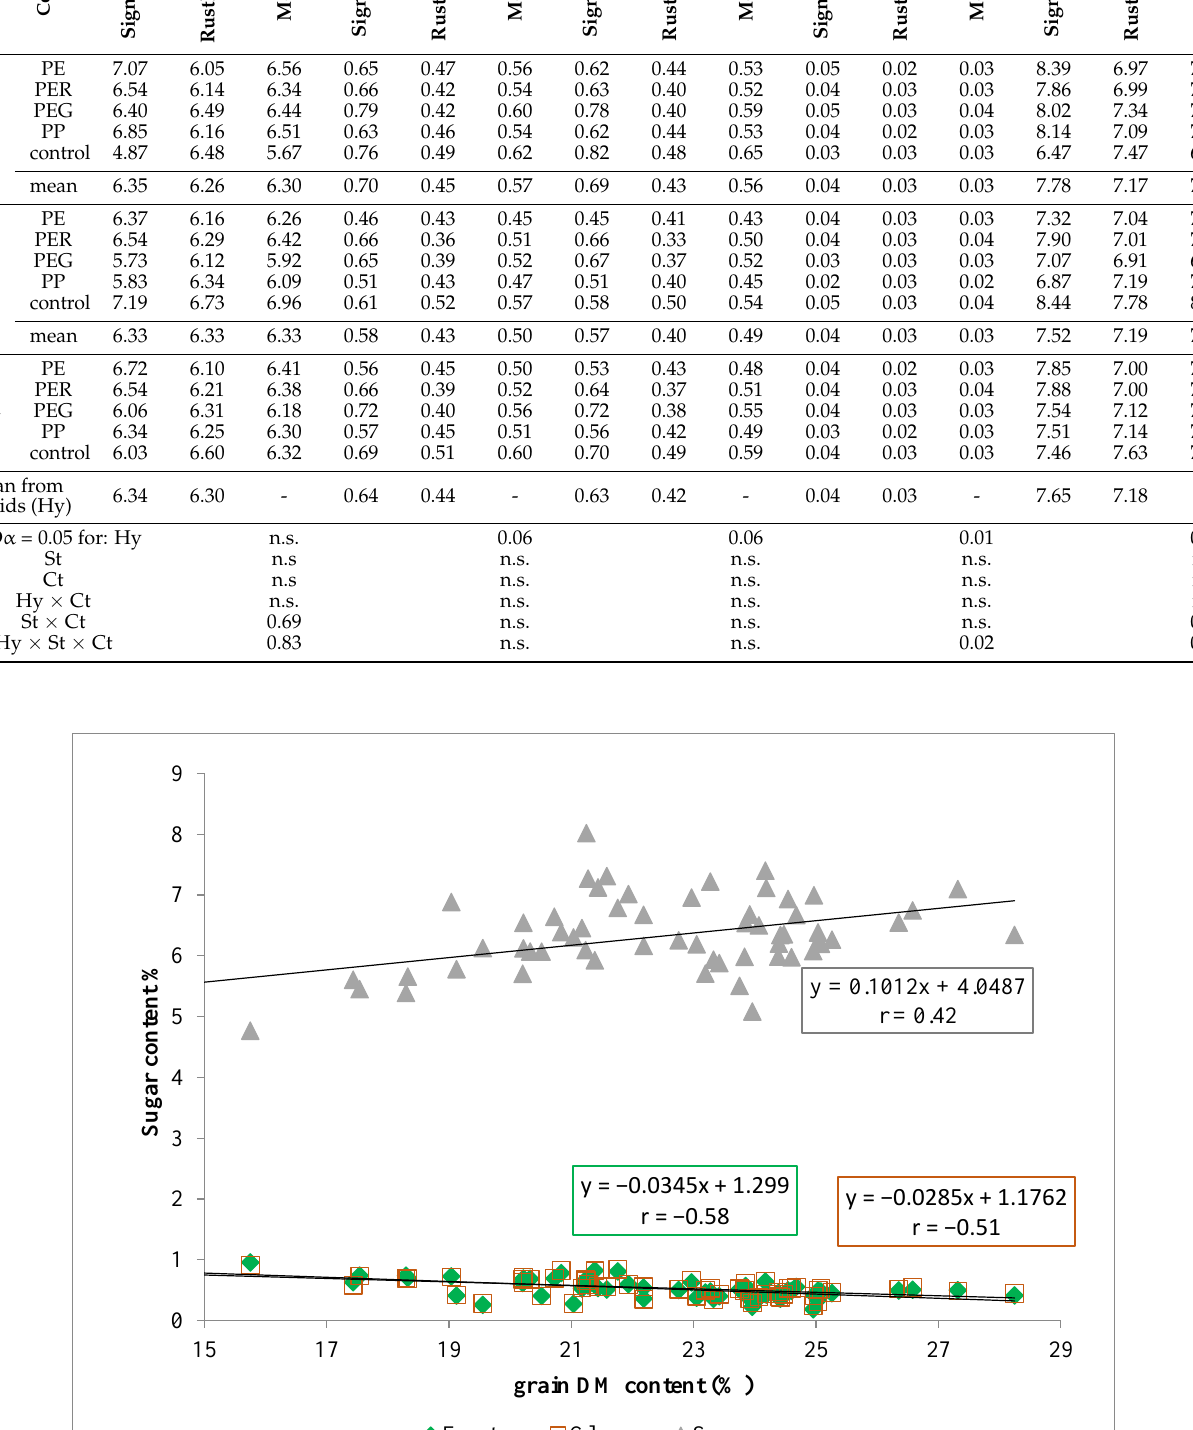
y = −0.0345x + 1.299